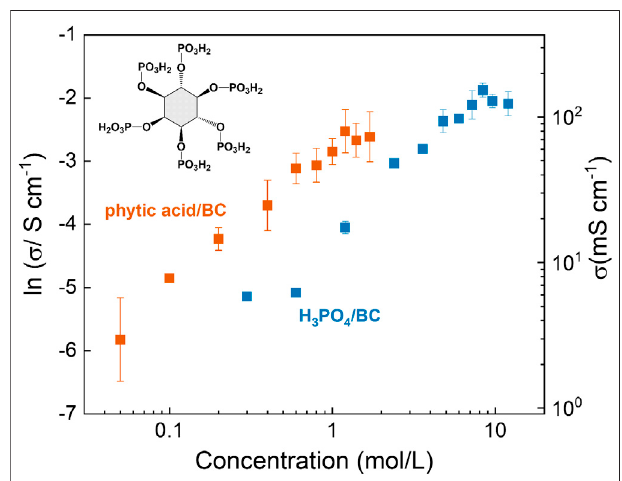
FIGURE13| In-planeprotonconductivityofBCmembranesdopedwith different amounts of phytic or phosphoric acid as a function of acid concentration in the impregnation solution. The inset shows the chemical structure of phytic acid. Redrawn from Jiang et al.